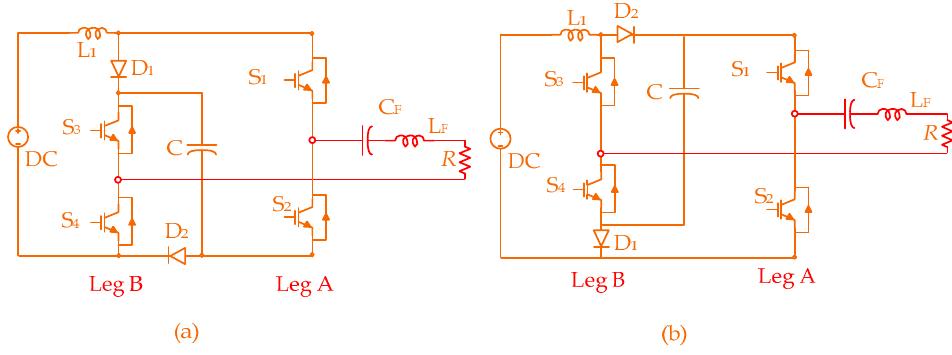
Figure 9. Four-switch quasi-switched boost inverter (FS-qSBI) topology ( a ) Type 1; ( b ) Type 2.